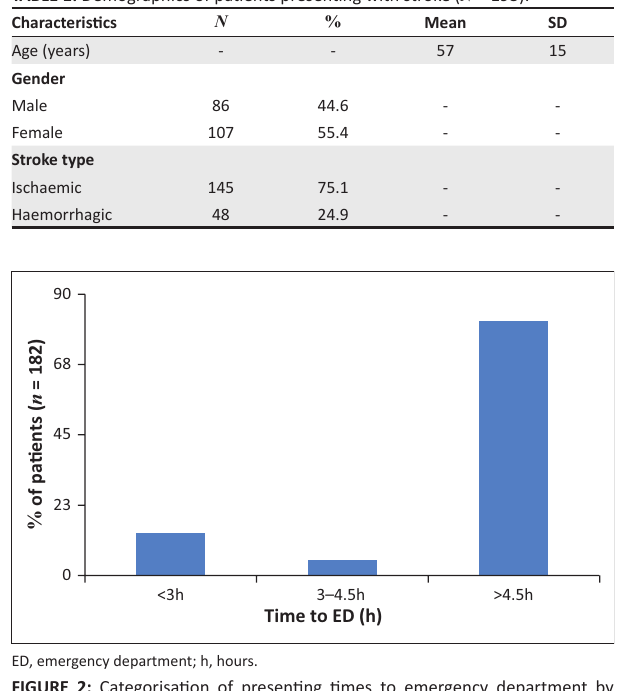
FIGURE 1: Identification of patients with potential stroke. FIGURE 2: Categorisation of presenting times to emergency department by thrombolytic window